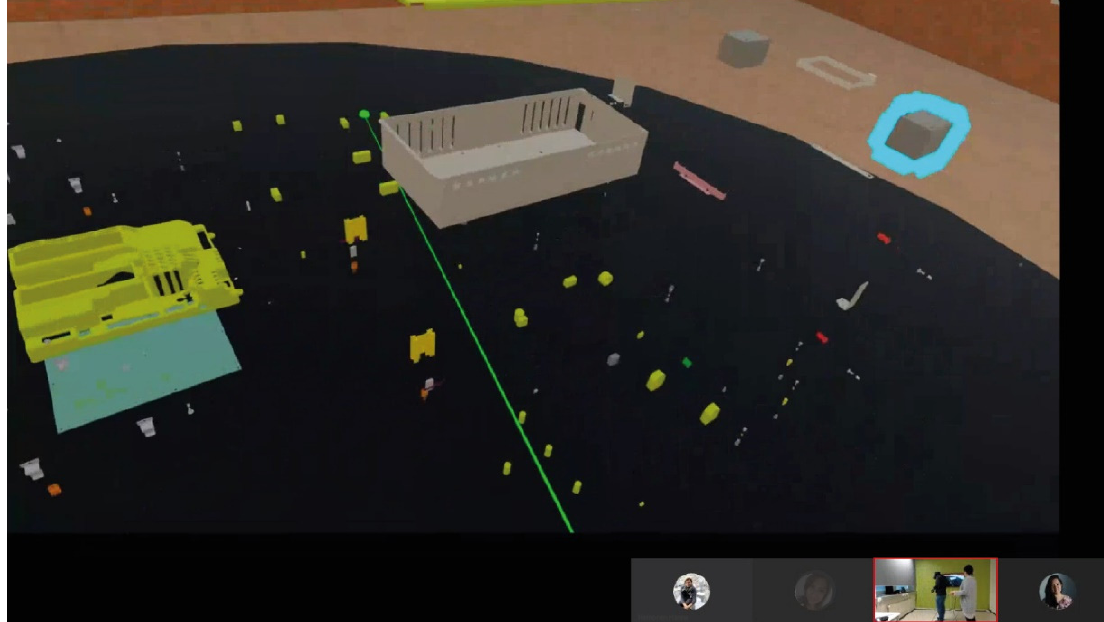
Figure 8. Single user evaluation observed via Teams. The HMDe participant’s view and USB camera view of the testing room were streamed for remote observers in Case 3. Figure 9. Network issues during remote observation in Case 3. The facilitator is seen twice in the image. 3.4. Case 4: Multi-User VR for Collaboration in Complex Machine Room Planning Case description: The use of a multi-user VR in complex elevator machine room planning of high-rise building projects was tested. The study aimed to find out the bene- fits of multi-user VR from the user and business perspective as well as how to optimally apply the technology in the process. Four real-life high-rise building projects in Indonesia, Malaysia, the United States, and the United Arab Emirates were studied. There were nine HMD participants who were members from the selected projects and company personnel from Finland. There were no participants from the Malaysian site because a COVID-19 national lockdown prevented them from accessing the VR facility. Three remote cross- country user tests were organized. Each test involved participants from two to three dif- ferent countries. Facilitation was conducted remotely, and the remote facilitator was in the virtual environment with the HMD participants. After each test, a group interview